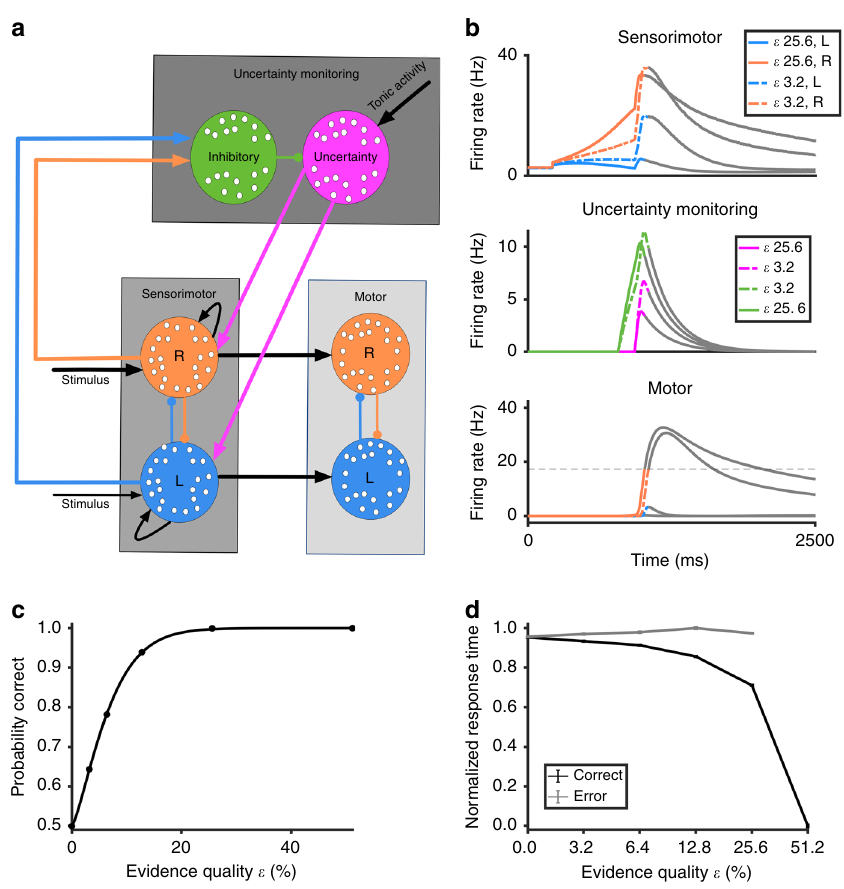
Fig. 1 Schematic diagram and performance of the distributed neural circuit model. a The model consists of three modules. The uncertainty-monitoring module consists of two neuronal populations. Inhibitory neuronal population (green) receives excitatory input (straight arrows) from output of sensorimotor module while inhibiting the uncertainty-encoding neuronal population (lines with fi lled circles), which in turn provides excitatory feedback to sensorimotor module. The uncertainty-encoding population (magenta) receives a constant tonic excitatory input that varies across trials in speci fi c cases (i.e. multi-stage paradigm, see “ Methods ” and below). The sensorimotor module consists of two competing (mutually inhibitory) neuronal